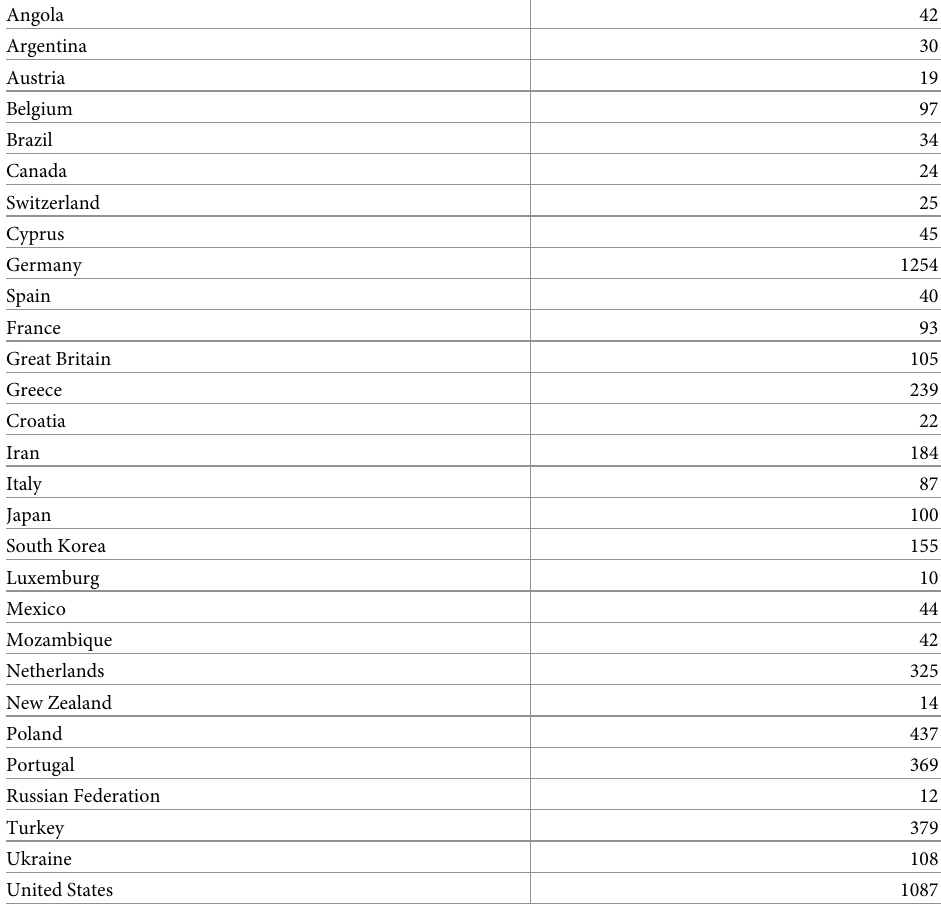
Table 1. Respondents in final sample by country of residence.